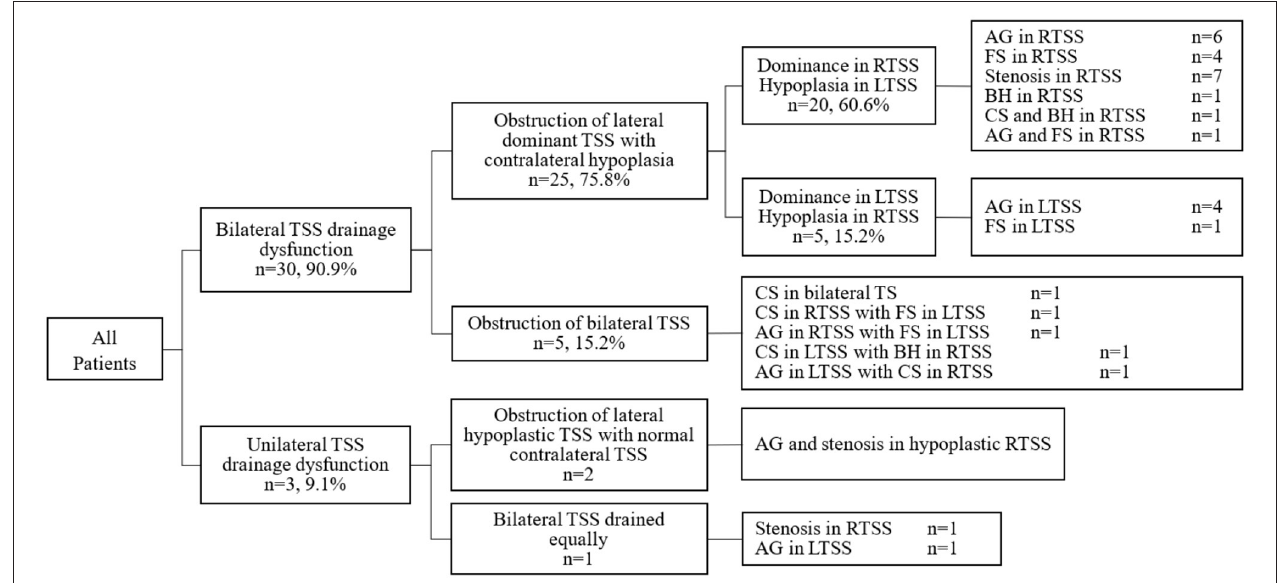
FIGURE 1 | The anatomic variations and drainage patterns in 33 enrolled patients with